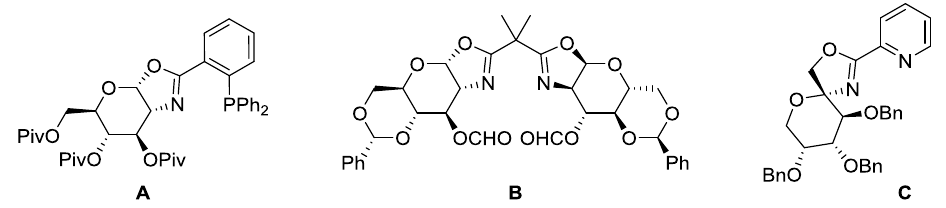
Figure 1. Examples of literature-known gluco PHOX ( A ), gluco BOX ( B ) and spiro PYOX ( C ) ligands.